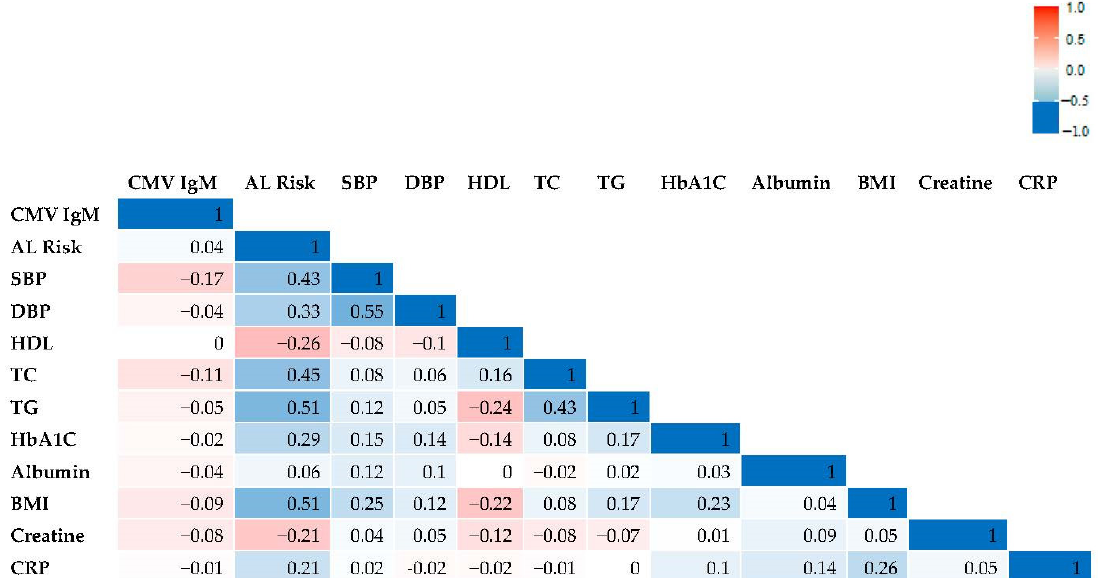
was not significant. The model indicated that age was significantly associated with AL. Table 3. Results of binary logistic regression for AL on CMV (IgM+/IgM − )—adjusting for the demo- graphic and behavioral factors. Model Variables